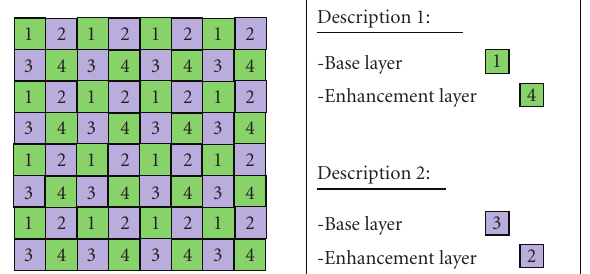
Figure 2: Subsampling patterns and descriptions composition for the case of quincunx